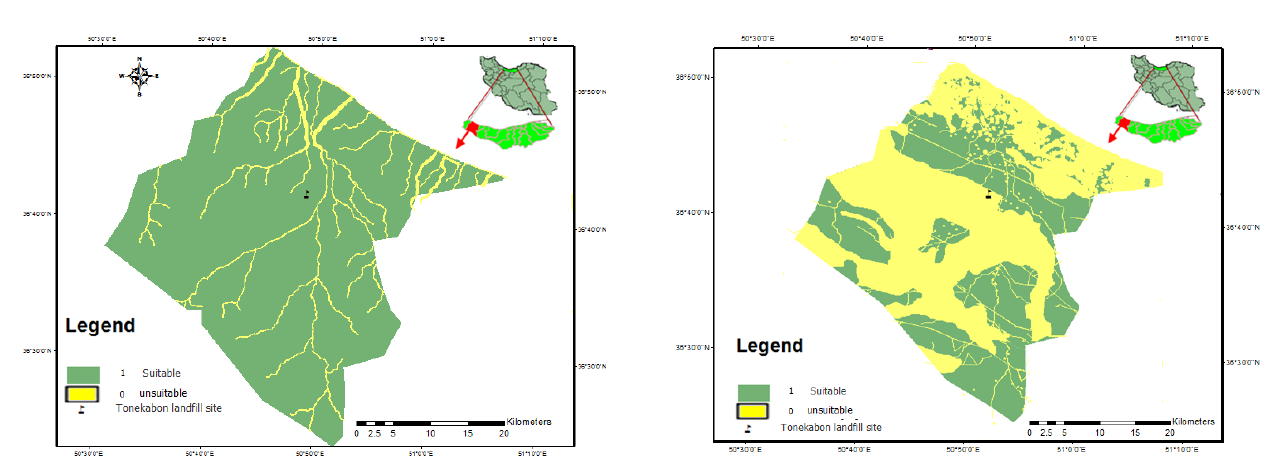
Figure 6. The suitability of the studied area based on MPCA deter- minative criteria.